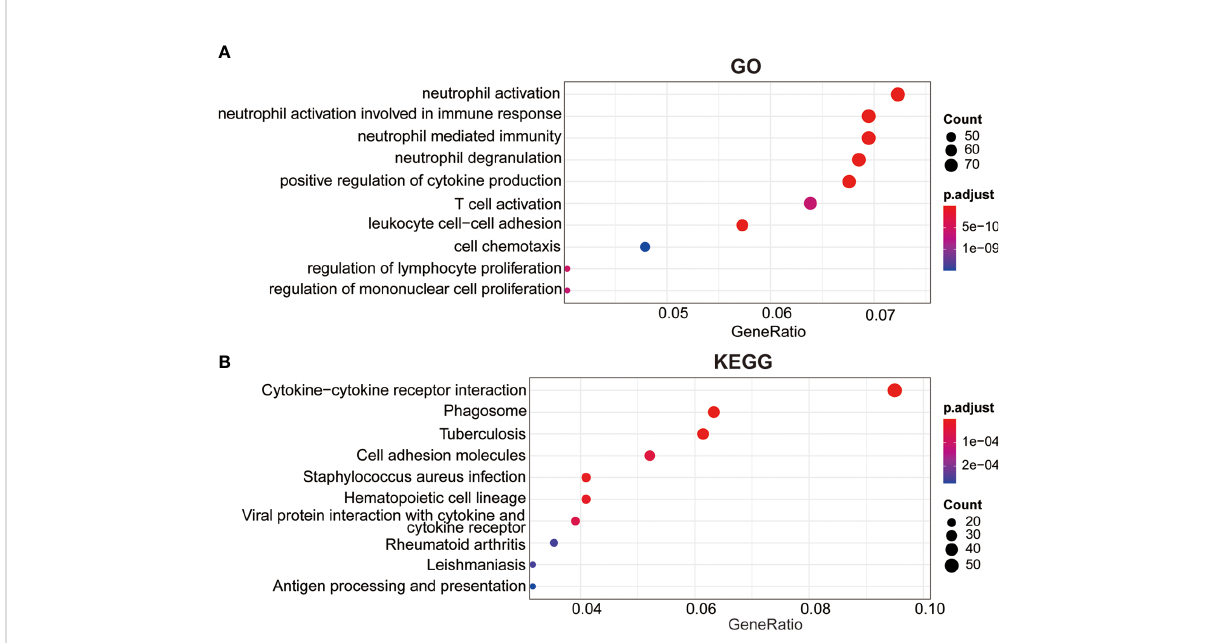
FIGURE 5 Cellular biological effects related to the signature. (A) Gene ontology (GO) biological process analysis. (B) Kyoto Encyclopedia of Genes and Genomes (KEGG) pathway